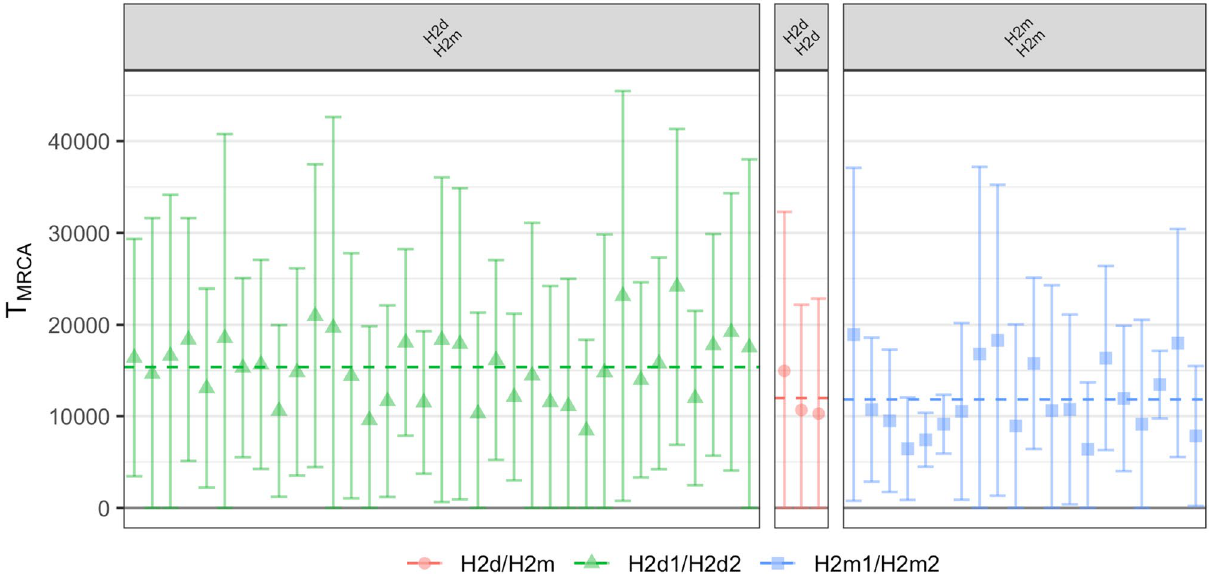
Figure 4. Estimated time since most recent common ancestor (T MRCA ) (y-axis) for each H2 subgroup with each other (facets), calibrated by the split time of ~ 163 kya of haplogroup A0 with all other Y haplogroups. All pairwise calculations are filtered to exclude individuals from the same sampling site. The dashed line indicates the mean estimate, and error bars indicate 95% confidence intervals for individual